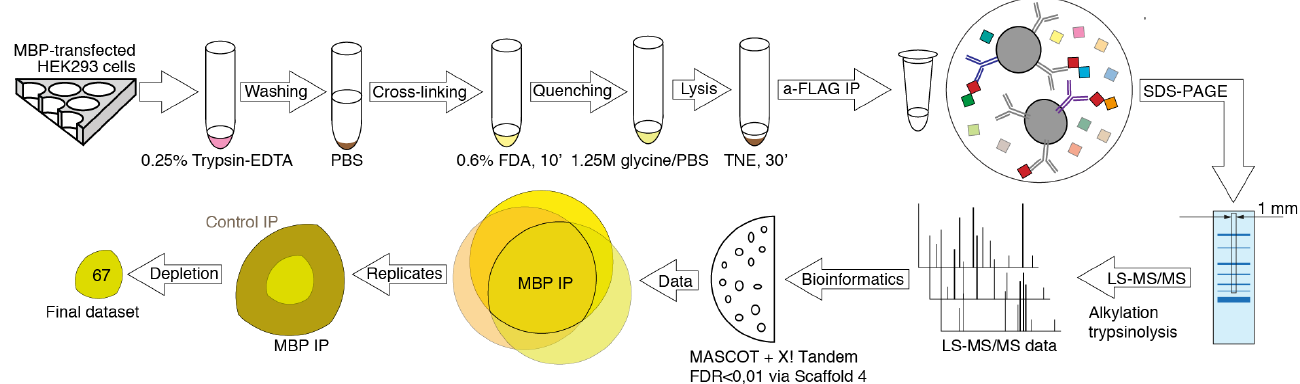
Figure 1. Experiment pipeline. HEK293T cells overexpressing Flag-tagged human MBP were detached, washed, and exposed to formaldehyde. The formaldehyde treated cells were washed and lysed in the mild conditions on ice. Protein complexes containing MBP were immunoprecipitated from the lysates using anti-Flag-agarose. The immunoprecipitated material was resolved by gradient SDS-PAGE. The cross-linked immunoprecipitated complexes were detected by Coomassie Blue staining. The 1 mm wide strips from the middle of each lane were cut and subjected to the in-gel-trypsinolysis procedure and mass spectrometry-based proteomics analysis. A total of three experiments were carried out with triplicate repeats in each.